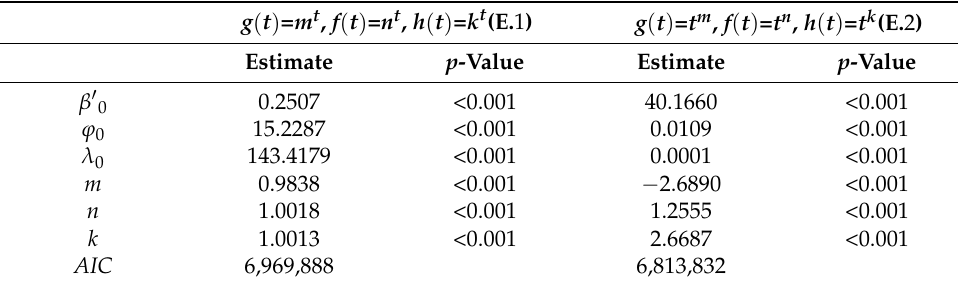
Table 5. Time-varying UIR and RDR estimated by Equation